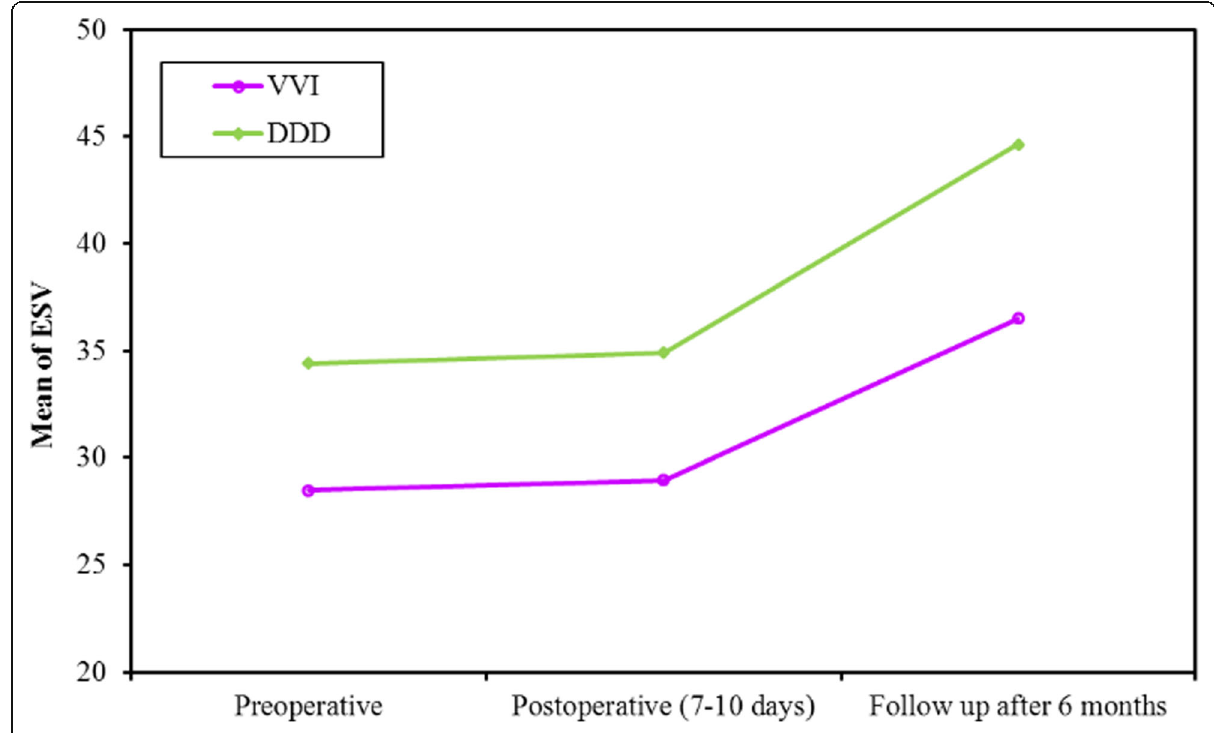
Fig. 5 Comparison between the different periods according to ESV in each